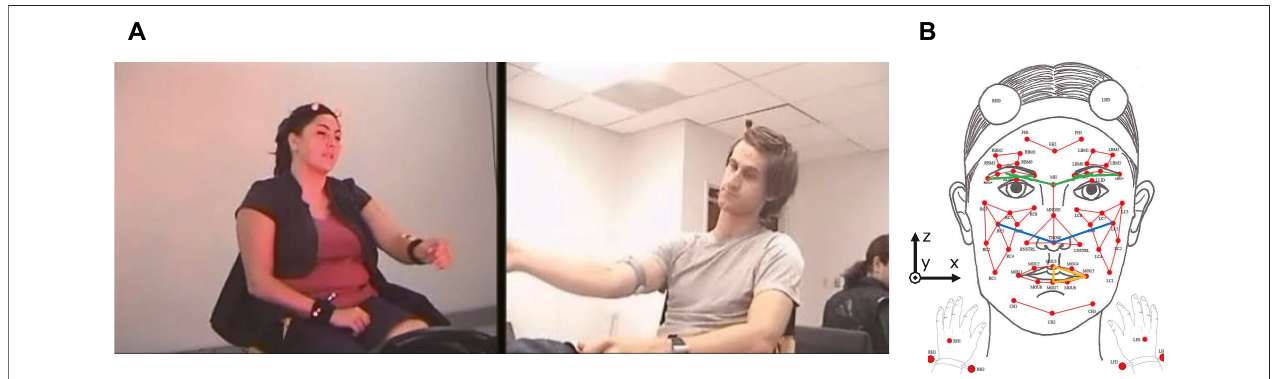
FIGURE 4 | Example interaction data from the IEMOCAP dataset (Busso et al., 2008) and the distances focused as facial movement features.